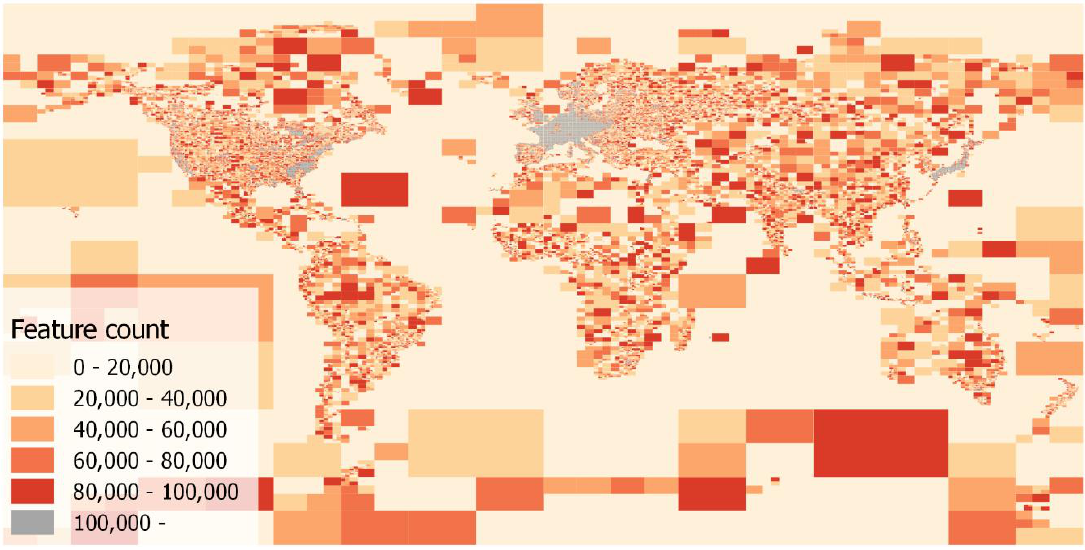
Figure 5. Quadtree structure representing the spatial indexing of the operations generated from September 2015 OSM Full History File (colors indicate the number of features within a cell).